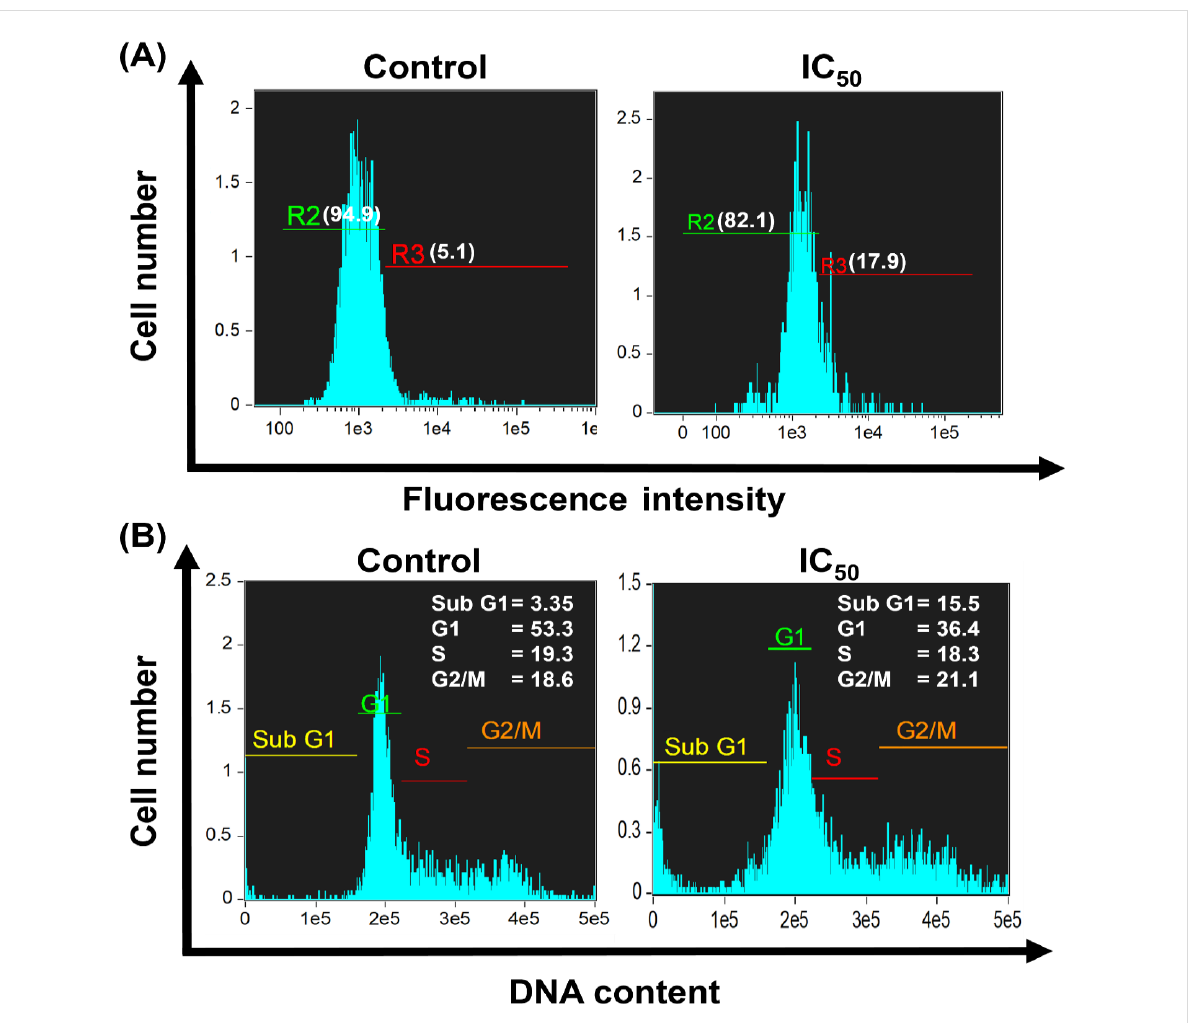
Figure 7: Flow cytometric analysis of (A) CellRox deep red for ROS quantification and intensity of propidium iodide (PI) fluorescence (B) for cell cycle analysis in IC 50 CaP@5-FU treated HCT-15 cells with respect to untreated